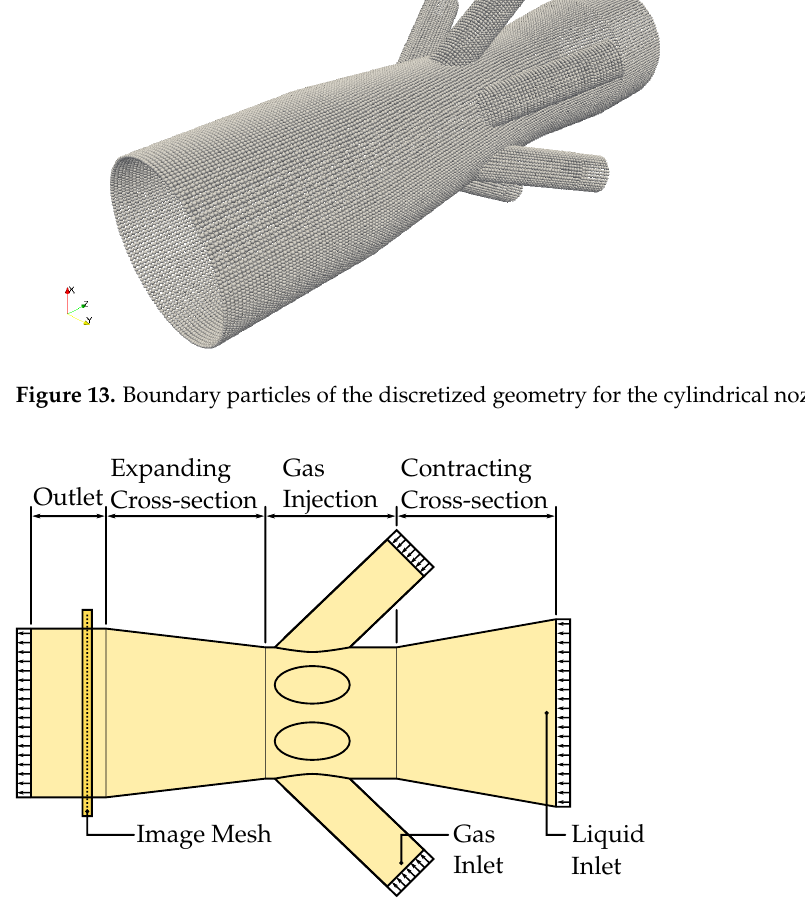
Figure 14. Schematic description of the fluid domain for the nozzle. Figures 15 and 16 show the images generated with both the outlet density and color gradient magnitude data for the cylindrical and elliptical cases, respectively. The color gradient does indeed capture the interface between fluids. Furthermore, the benefits of using the color gradient can be seen as it highlights fine structures due to diffuse mixing as well.